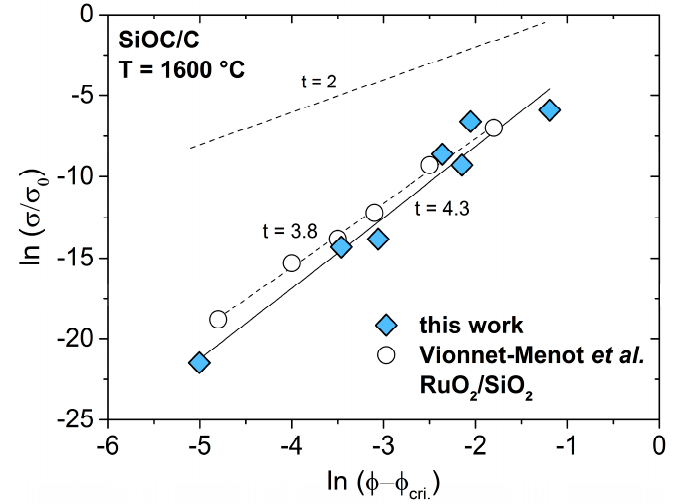
Figure 6. Electrical conductivity of SiOC / C materials as a function of the sp 2 carbon concentration. Table 1. The upper dashed line represents the universal behavior with a slope of t = 2. The empty circles represent the electrical conductivity of piezoresistive RuO 2 / silica composites with varying RuO 2 content